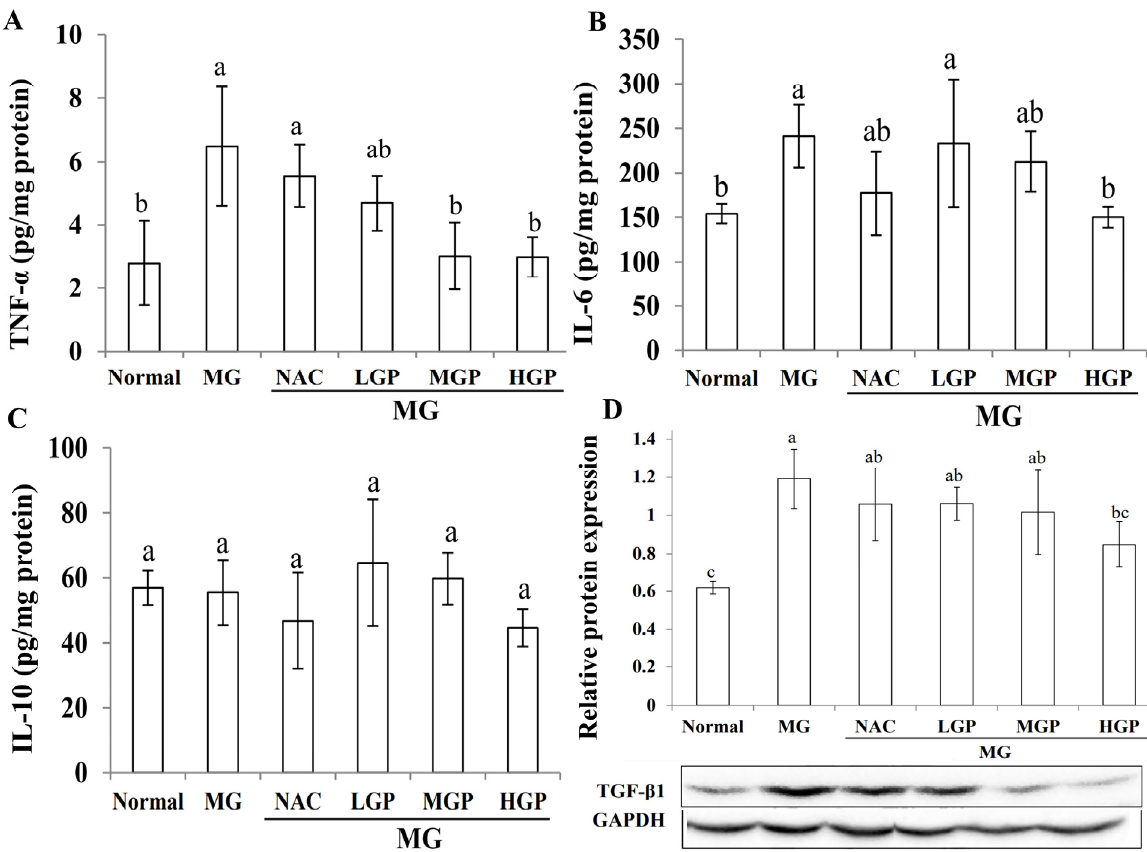
Figure 1. Effects of WGP on cytokines such as ( A ) TNF- α , ( B ) IL-6, ( C ) IL-10 (ELISA measurement), and ( D ) TGF- β (Western blot) contents in the livers of MG-treated rats. Each value is expressed as the mean ± SD ( n = 6). a–c Values in a column with different superscripts are significantly different ( p < 0.05). MG, 195 mg/kg bw; NAC, 100 mg/kg bw; LWGP, low-dose WGP (50 mg/kg bw); MWGP, medium-dose WGP (250 mg/kg bw); HWGP, high-dose WGP (500 mg/kg bw); WGP, water extract of G. paraguayense E. Walther; MG, methylglyoxal; NAC, N -acetyl-L-cysteine.